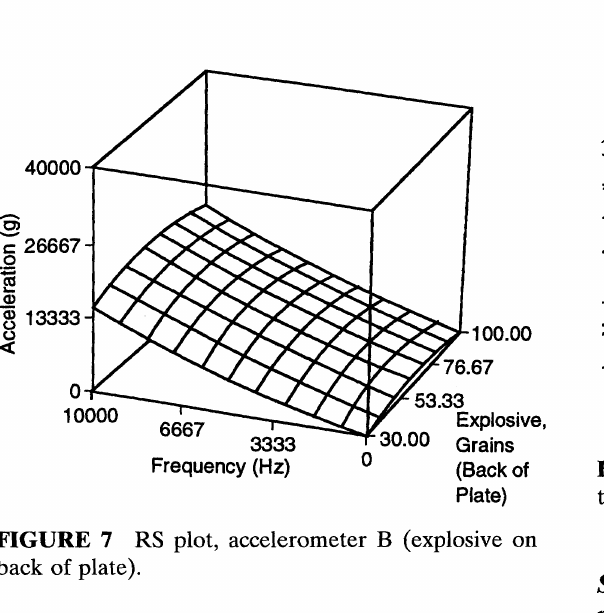
FIGURE 7 RS plot, accelerometer B (explosive on back of plate).